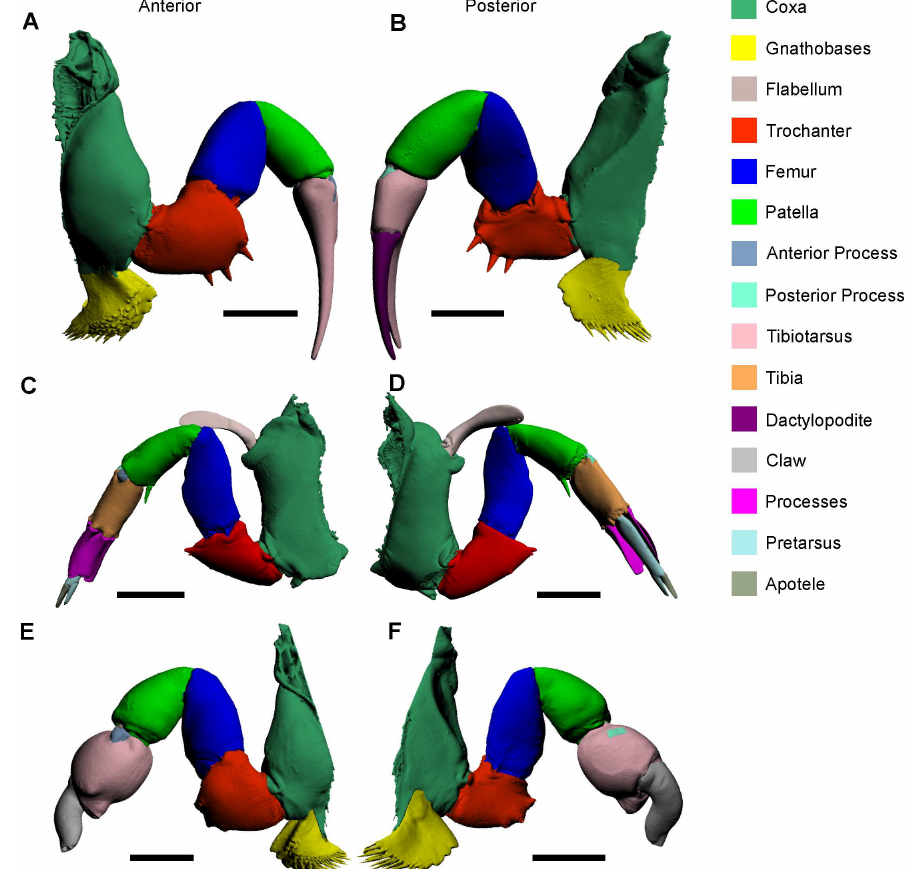
Fig 3. 3D reconstructions of the walking leg (A, B), pushing leg (C, D), and male pedipalp (E, F) as modelled from micro-CT scanning. Reconstructions in the left column (A, C, E) are all anterior views and reconstructions in the right column (B, D, F) are all posterior views. These reconstructions should be studied in conjunction with the muscle reconstructions in Fig 4. The 3D versions of these files are available in the Supporting Information (S3, S4 and S5 Figs). Scale bars 15 mm for A, B, E, F; 20 mm for C,